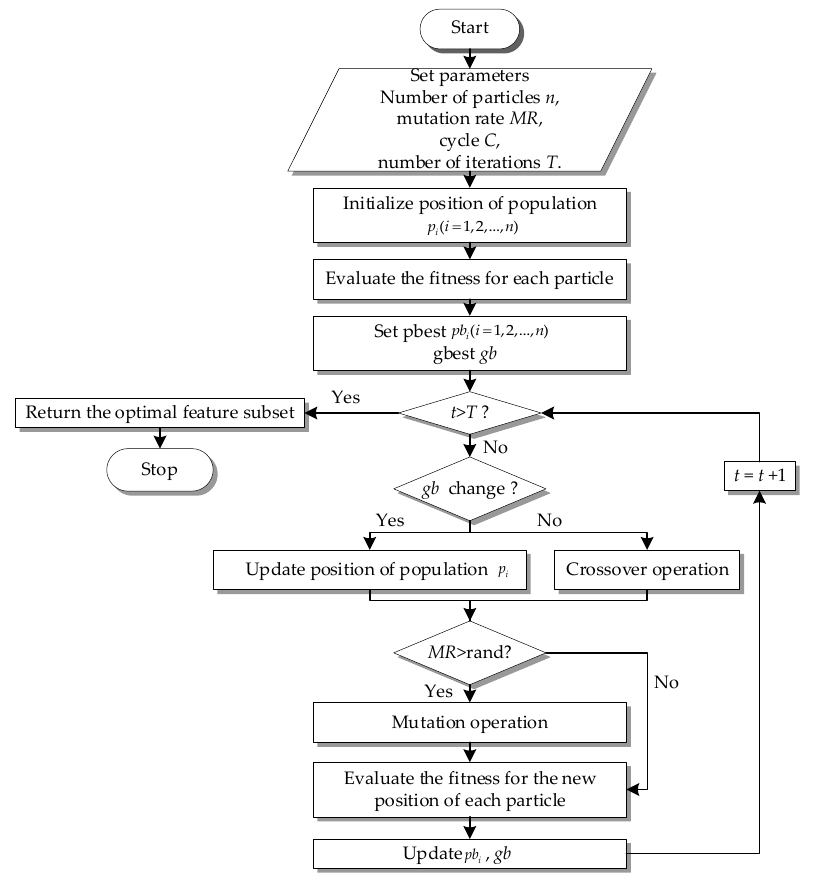
Figure 2. The procedure of